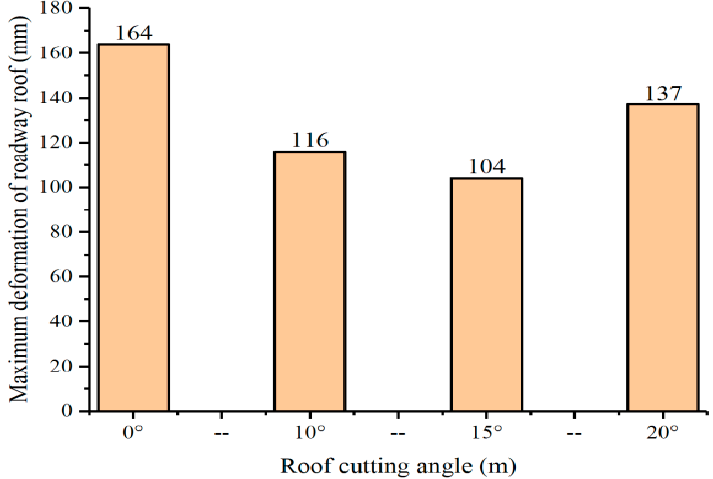
Figure 9. Maximum deformation of the roadway roof for different cutting angles.